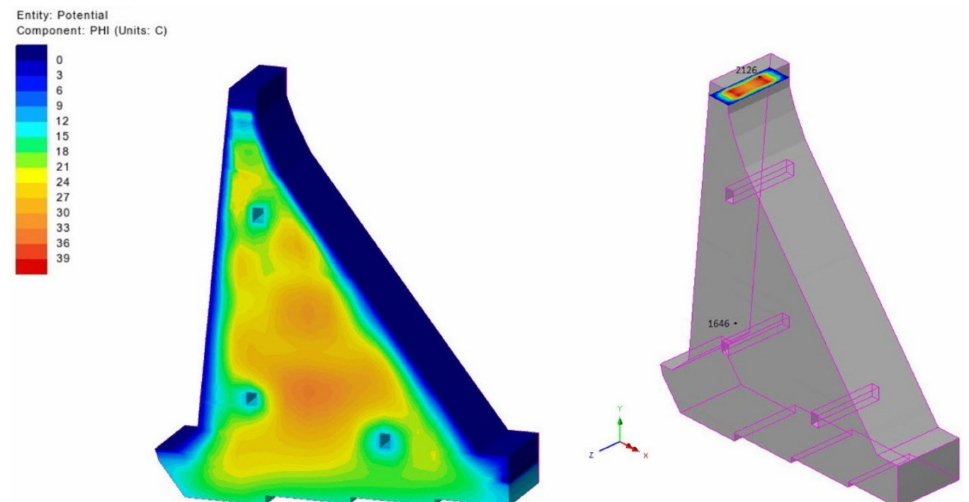
Figure 16. Temperature field for day 512 (13th of March of the third year) with horizontal cross-section at 227.0 masl; maximum: node 2126, minimum: node 1646.